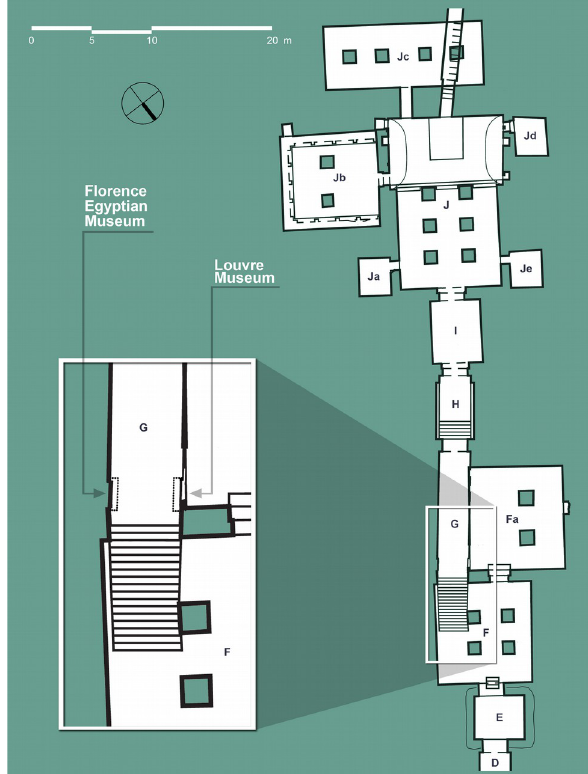
Figure 1. Plan of the tomb KV17 with the indication of the removed jambs of the gate G. (elaboration from K. Weeks, The Theban Mapping Project, sheet